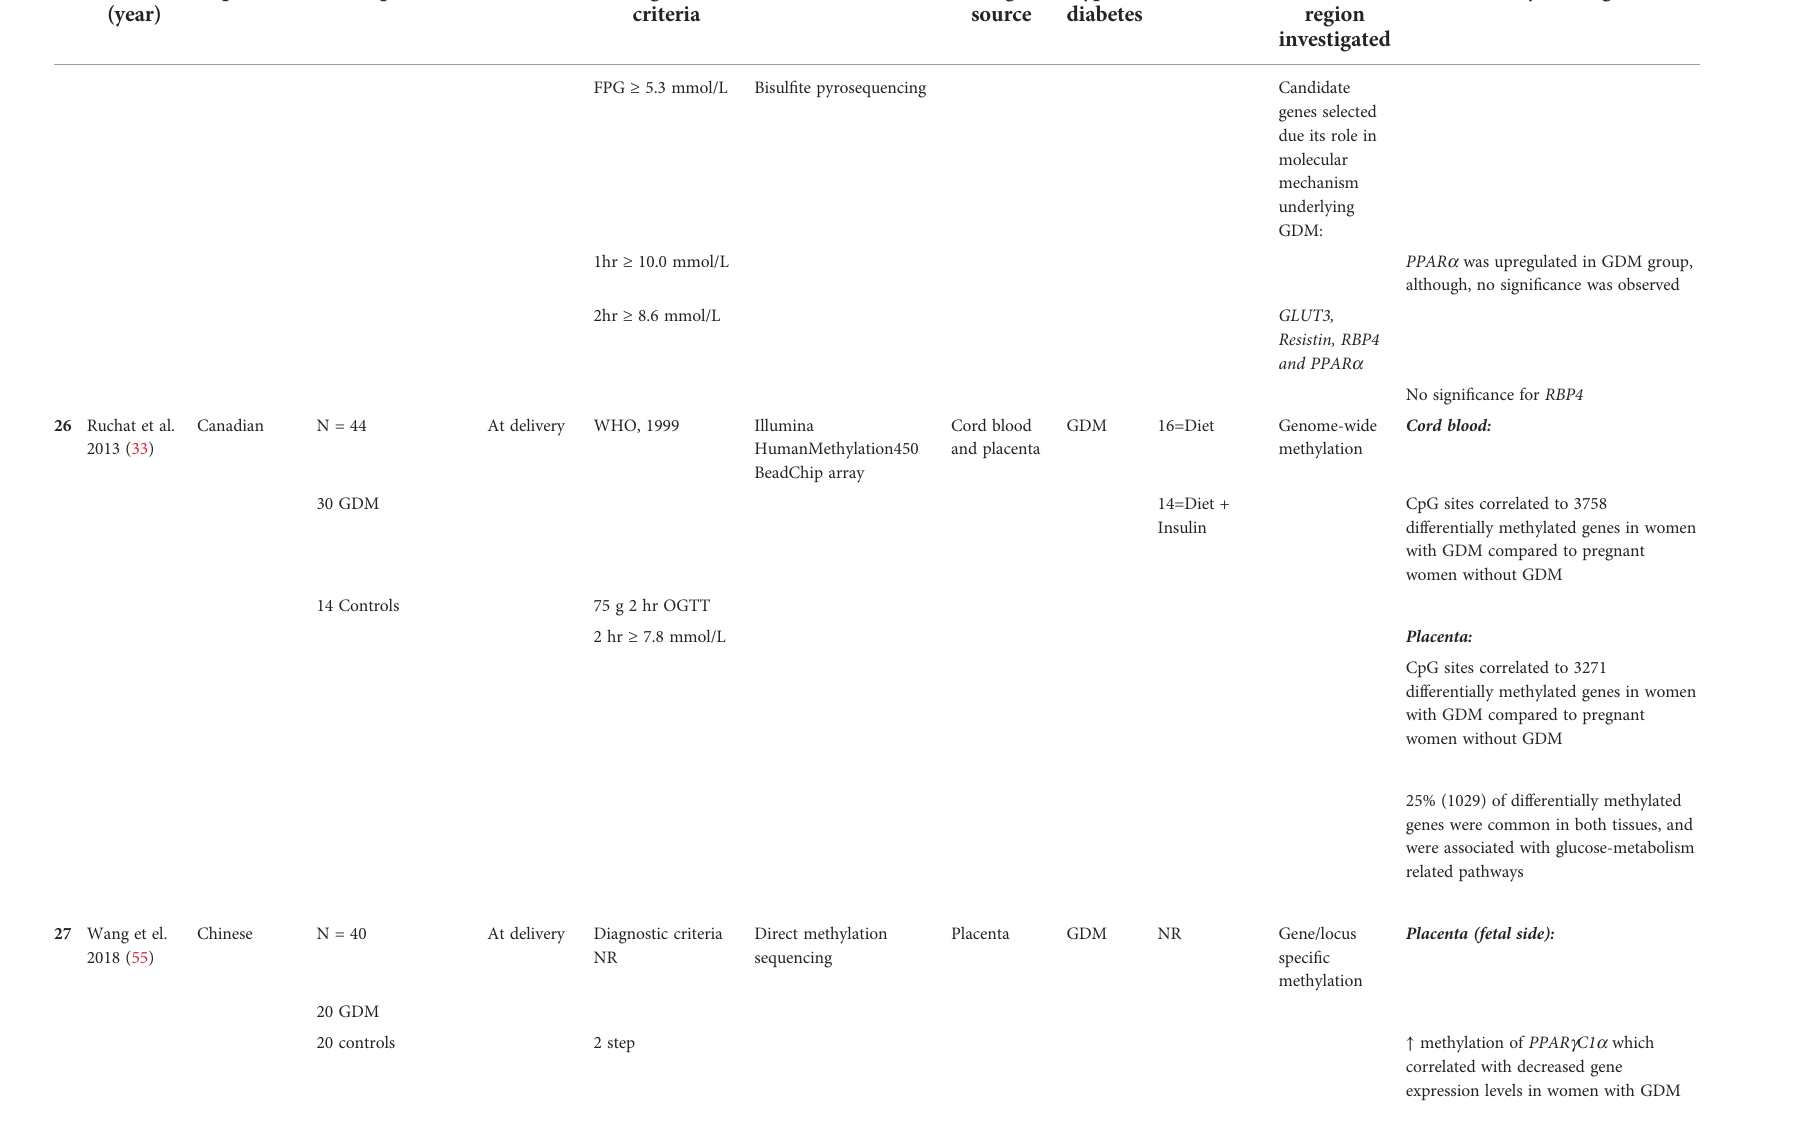
CpG sites correlated to 3271 differentially methylated genes in